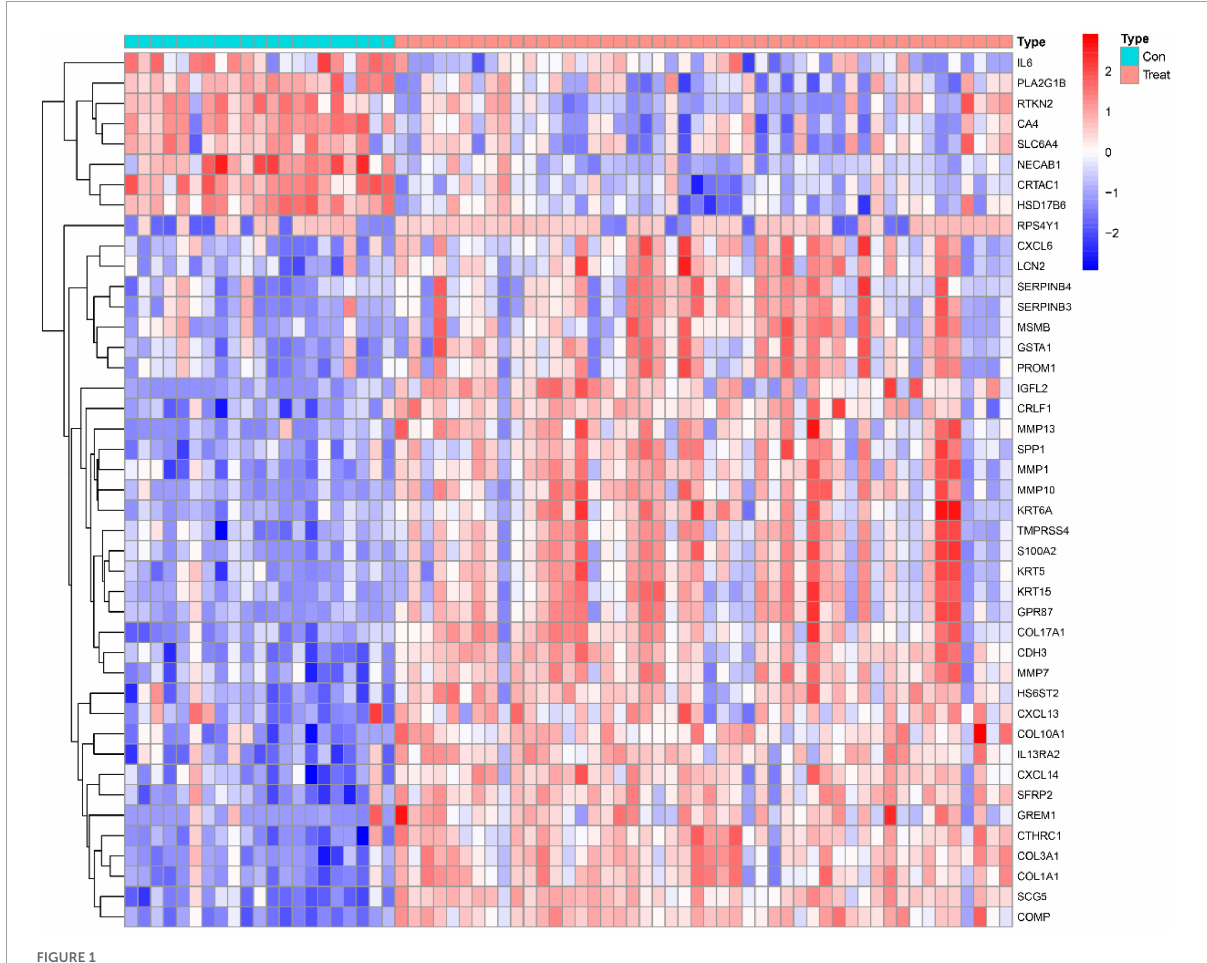
FIGURE1 IPF-related genetic heat